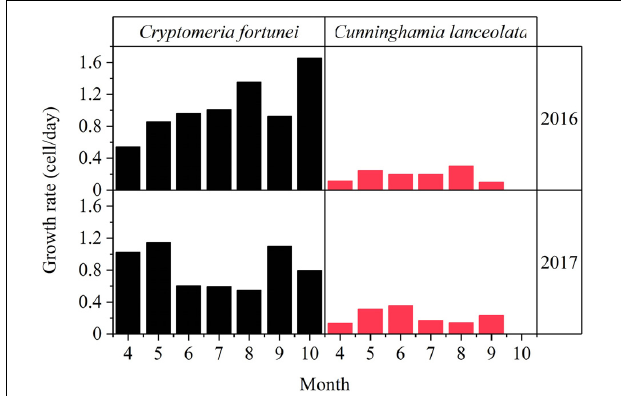
FIGURE 4 | Monthly growth rates of Cryptomeria fortunei (left) and Cunninghamia lanceolata (right) as observed during the growing season of 2016–2017.